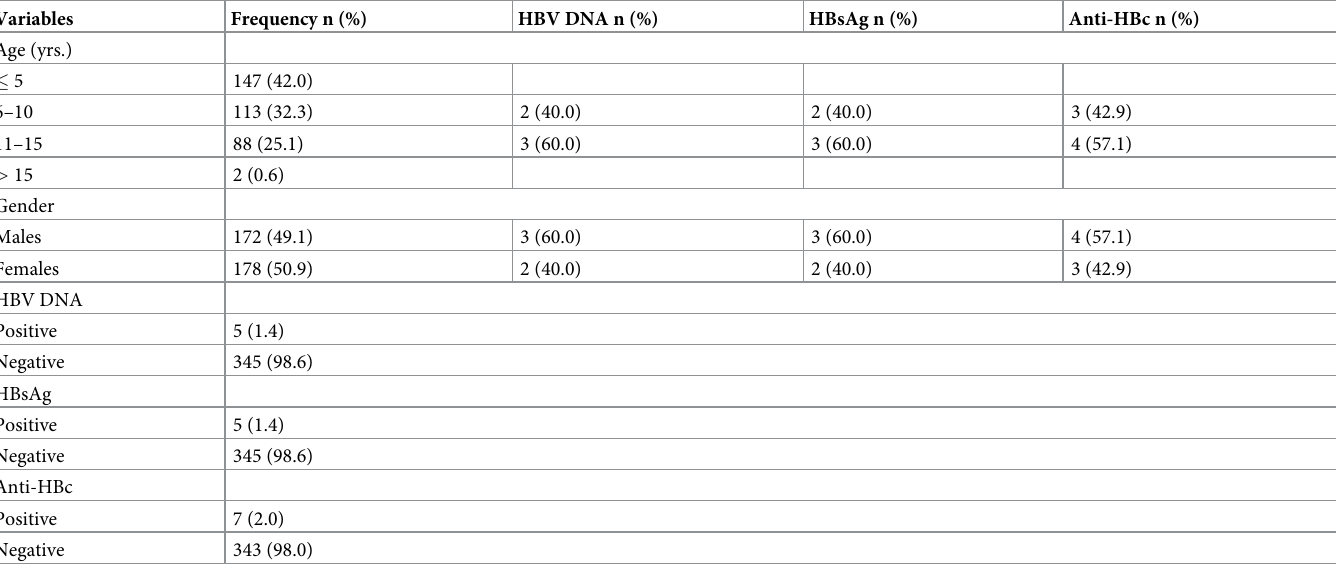
Table 3. Distribution of serological and molecular markers of HBV in relation to